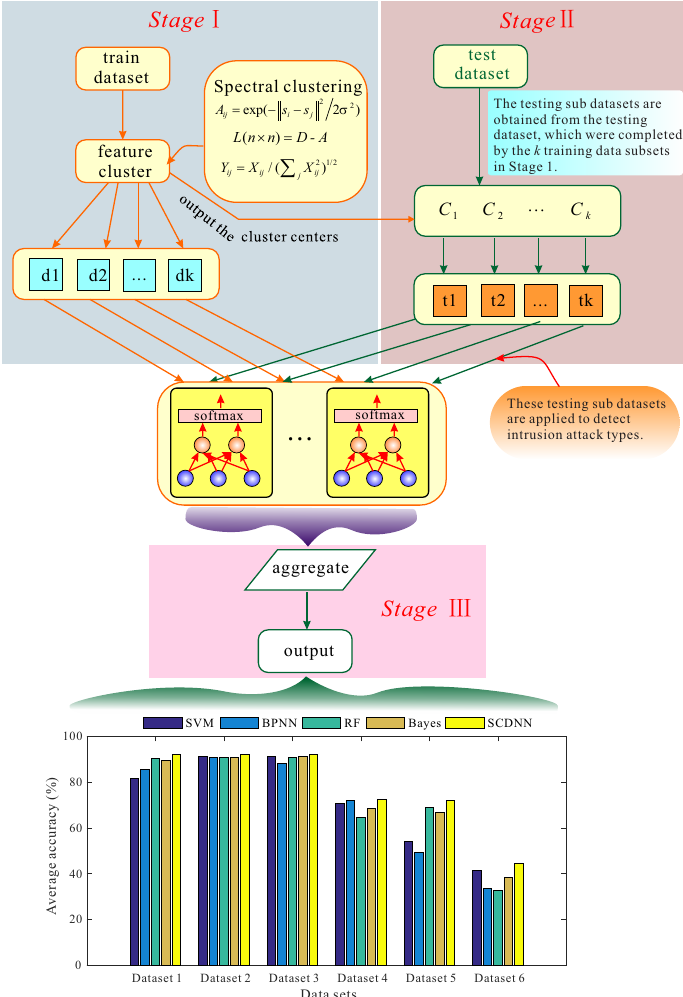
Figure 2. The SCDNN flow chart is divided into three steps and shows each process in detail.